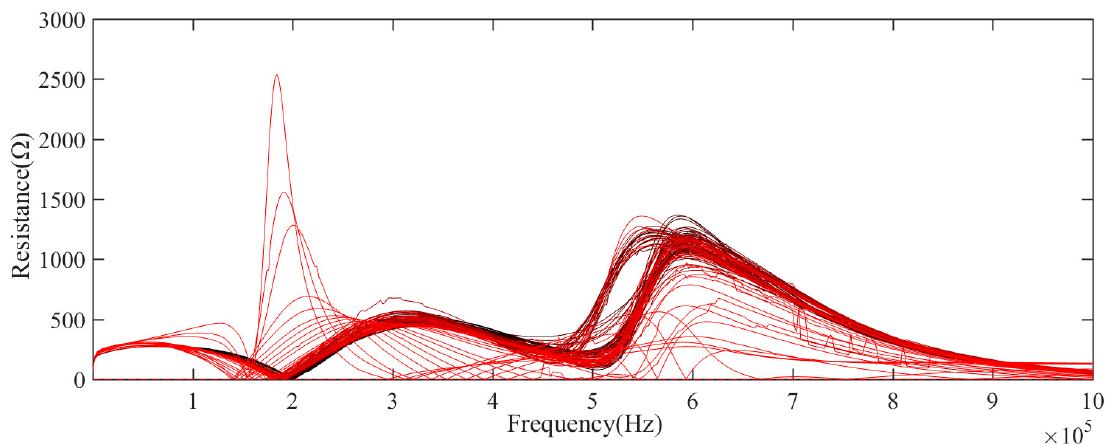
Figure 4. The measurement value of impedance spectra of the electromagnetic coil in the whole life.